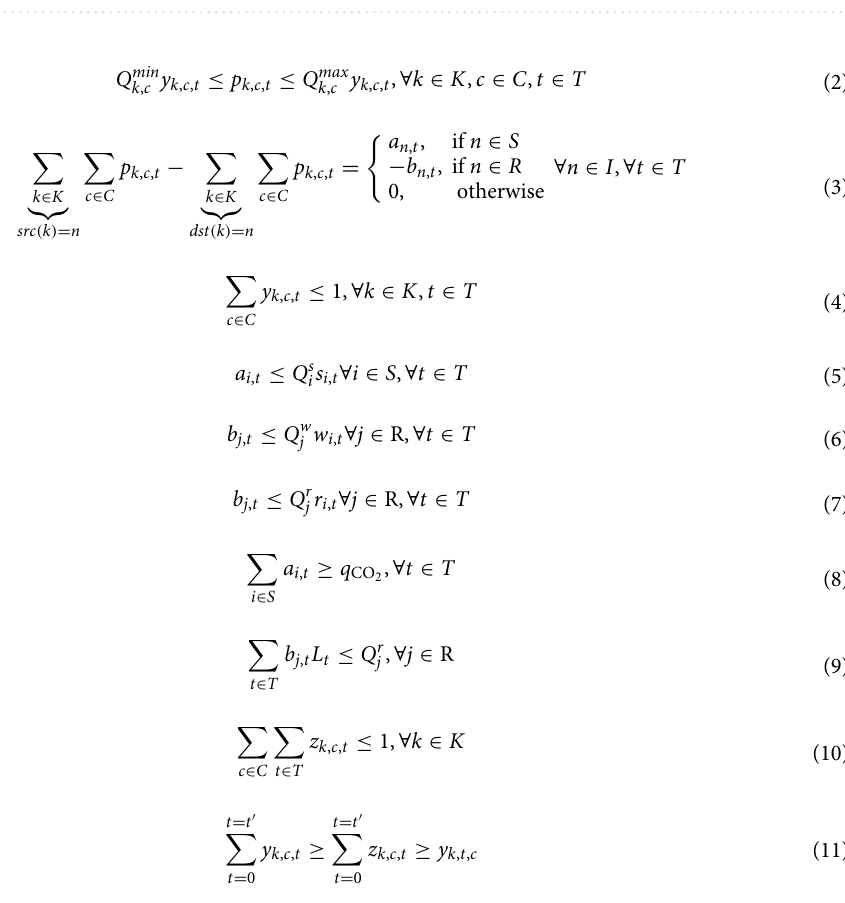
Table 2. Basic input parameters for CCS pipeline modeling in SimCCS 3.0